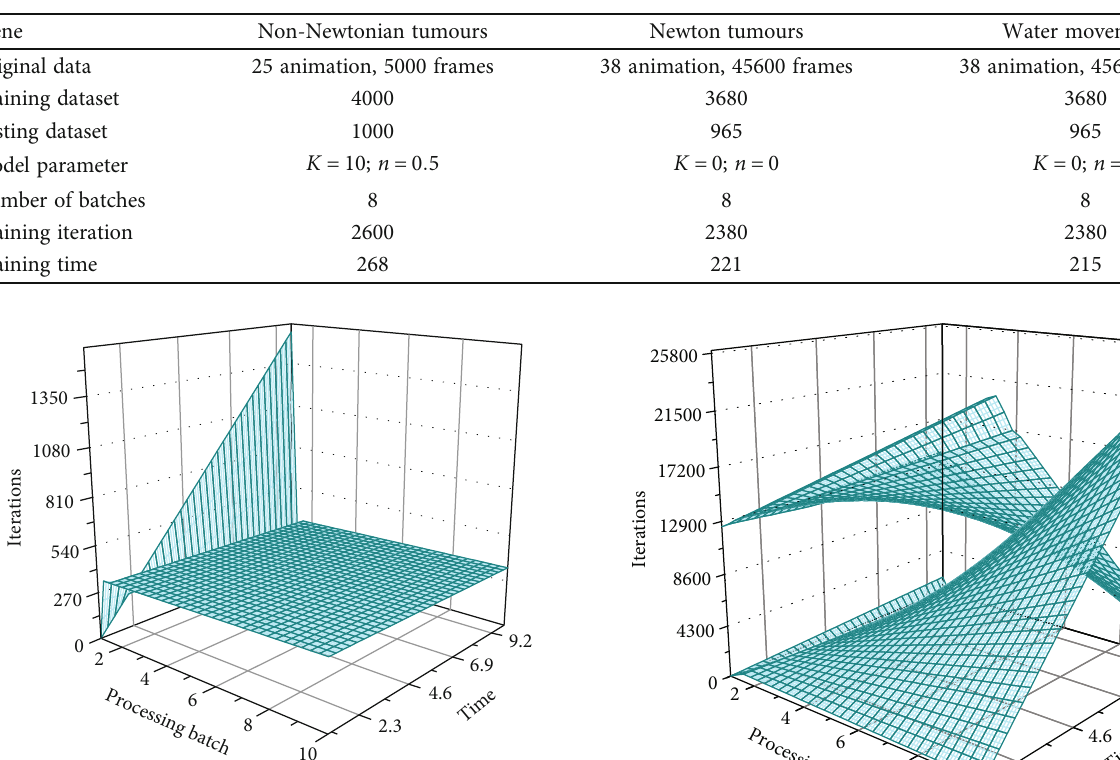
Figure 3: FluidsNet overall structure diagram. Table 1: The complete training details.